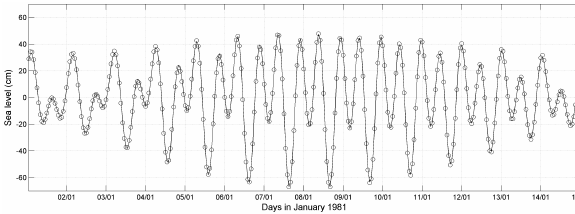
Fig. 10. Sea level in Trieste for the first two weeks in 1981 derived from a seven-constituent analysis of a five-year time series (circle) and seven-constituent model prediction (solid line).